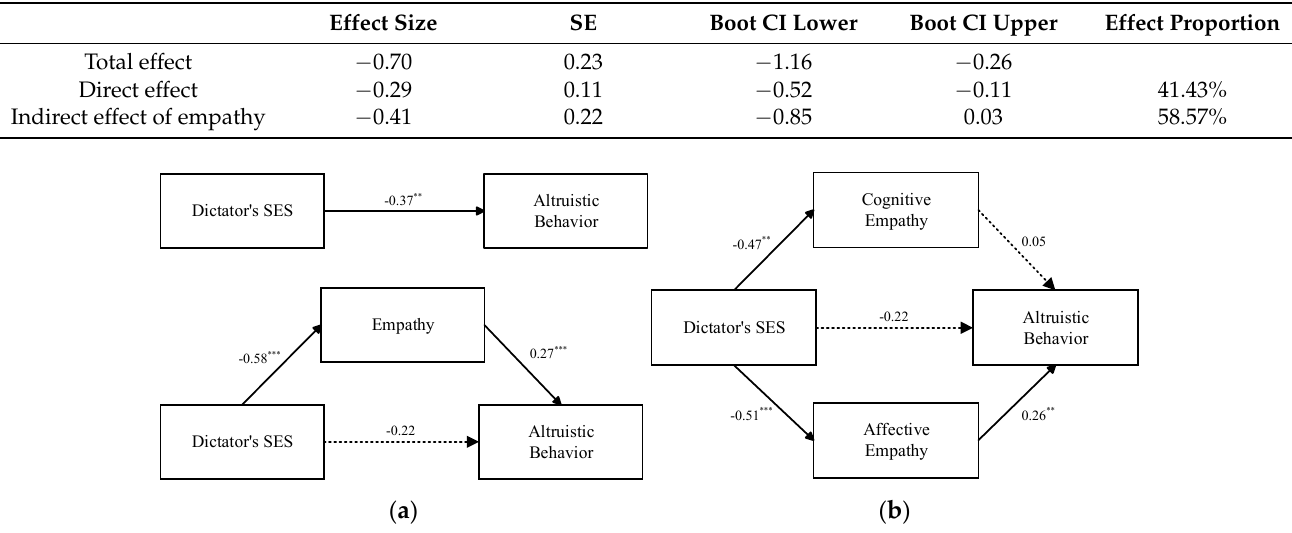
Table 3. Regression coefficients, standard errors, and effects for the hypothetical mediation model (empathy as mediator).